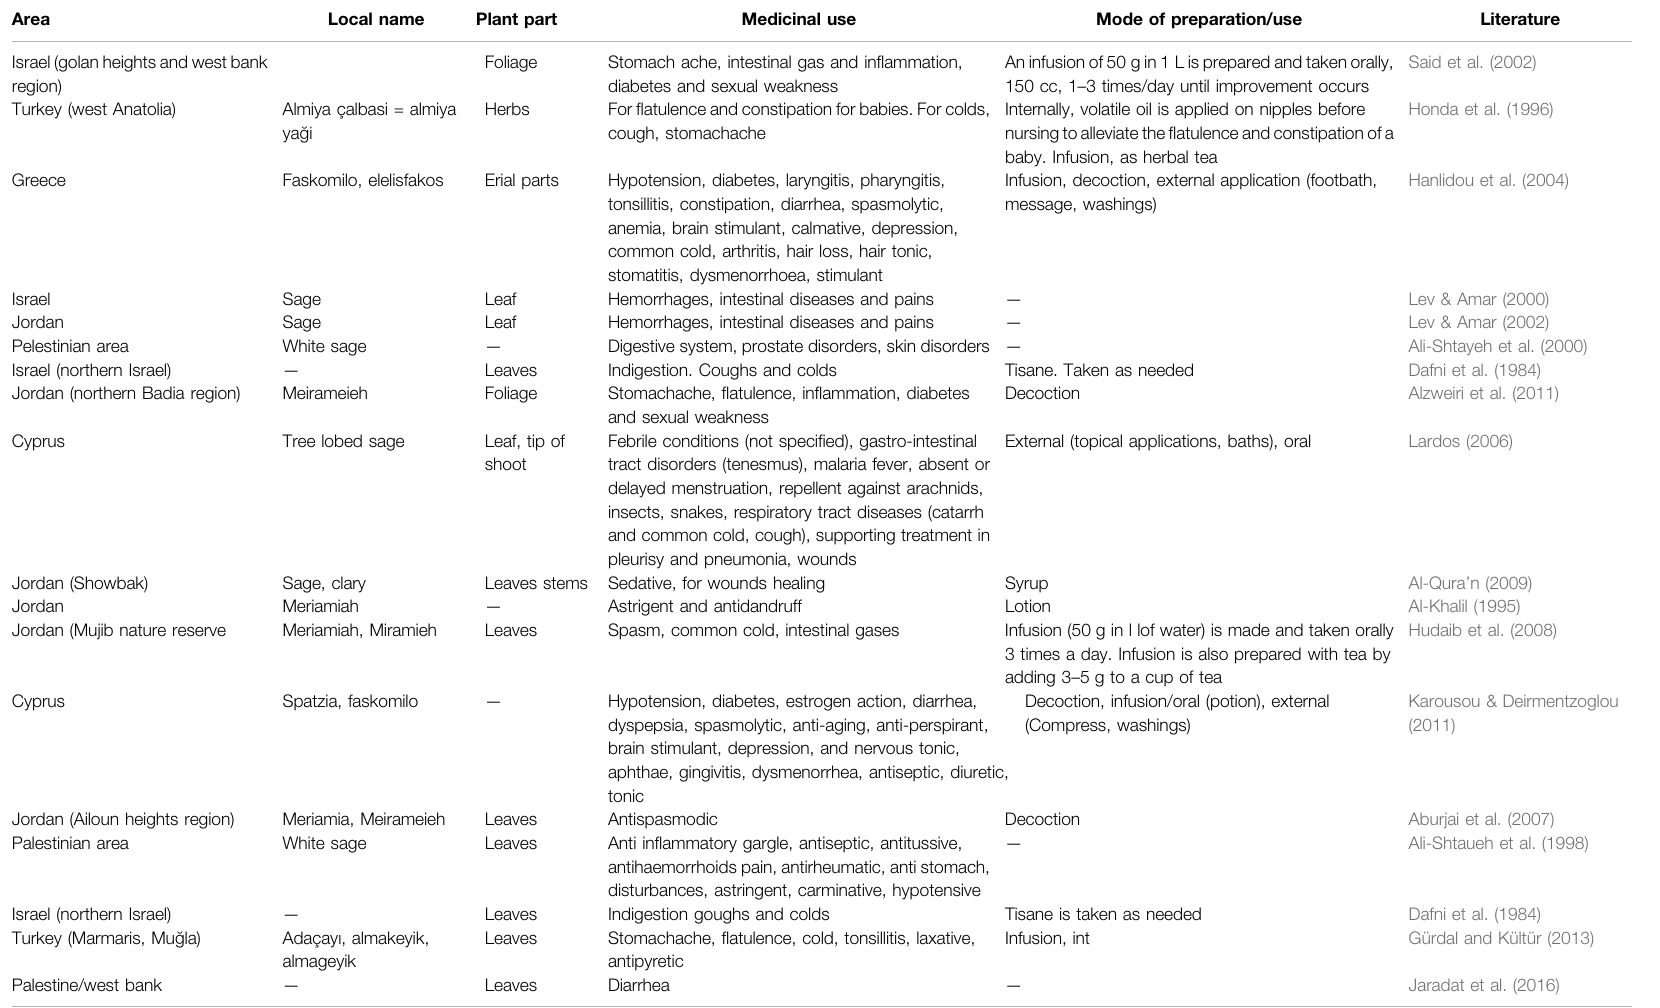
TABLE 2 | Medicinal uses of Salvia fruticosa derived from ethnobotanical and ethnopharamacological